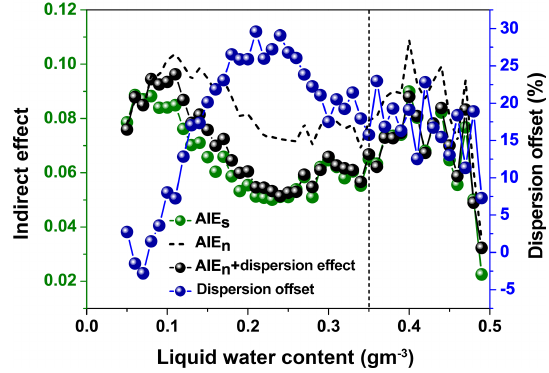
Figure 8. Aerosol indirect effect estimated after considering disper- sion effect in AIE n : left axis represents AIE; right axis represents dispersion offset in